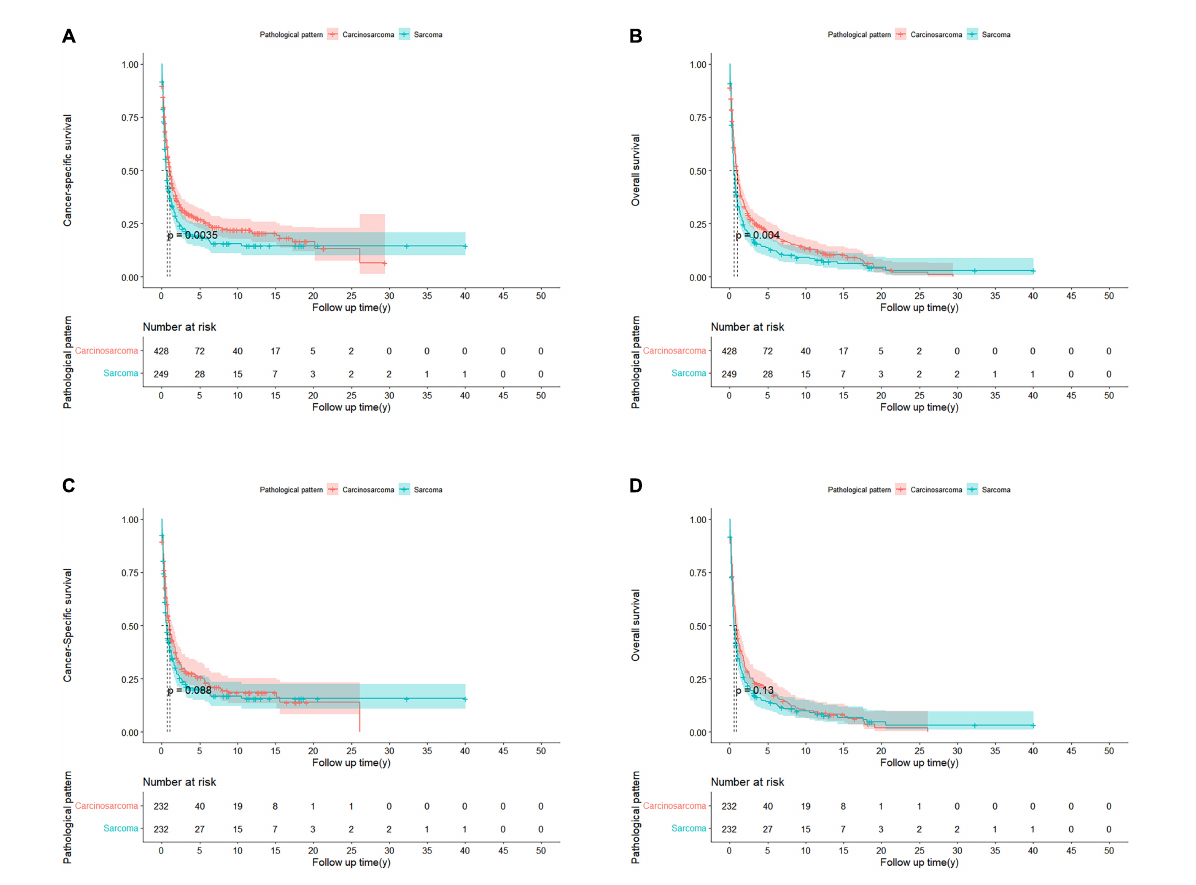
FIGURE2 Kaplan-Meier curves of patients with PCS and PS in unmatched and matched cohorts. Before PSM, CSS (A) and OS (B) in patients with PCS and PS. After PSM, CSS (C) and OS (D) in PCS 1:1 matched with PS